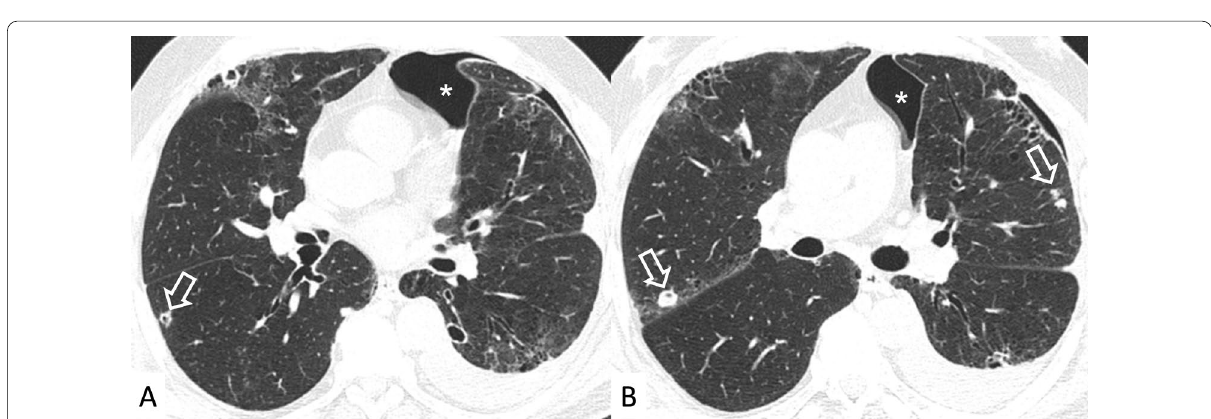
Fig. 8 Cavitate nodular lesions (white empty arrows in A , B ) in a male RA patient. Rheumatoid nodules represent a rare manifestation of disease; generally, they have bilateral and subpleural location, with rounded shape. The development of cavitation has been reported in literature related to vasculitis. Left pneumothorax (white asterisk) is also evident along the anterior part of the